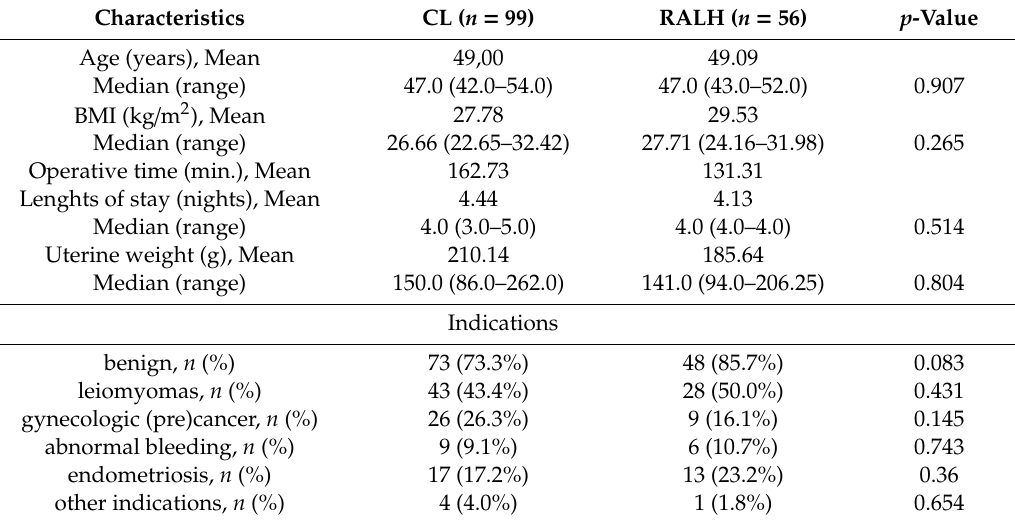
Table 1. Characteristics of the study population, indications and complications by the hysterectomy